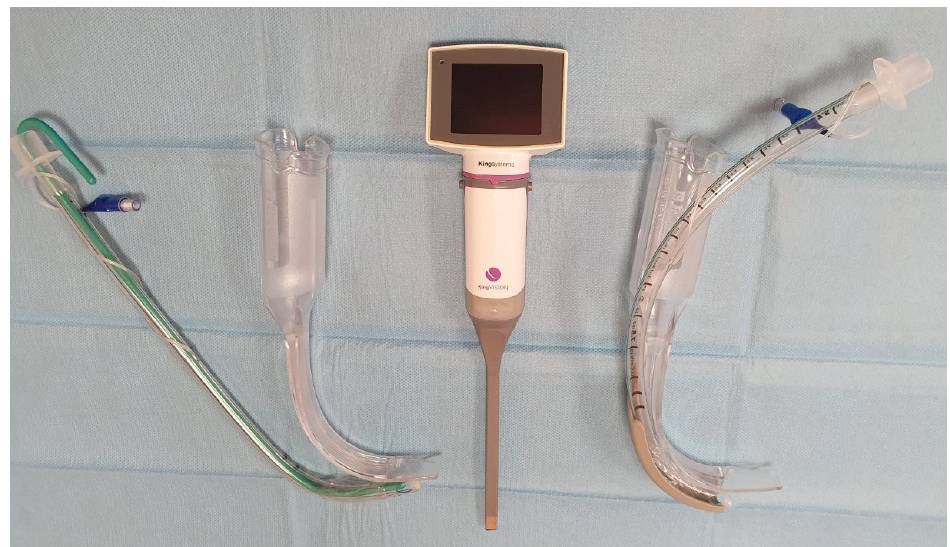
Figure 2. Interchangeable channeled (right) and non ‐ channeled (left) blades of the King Vision TM video laryngoscope. A tracheal tube is preloaded to the guiding channel of the channeled blade, while